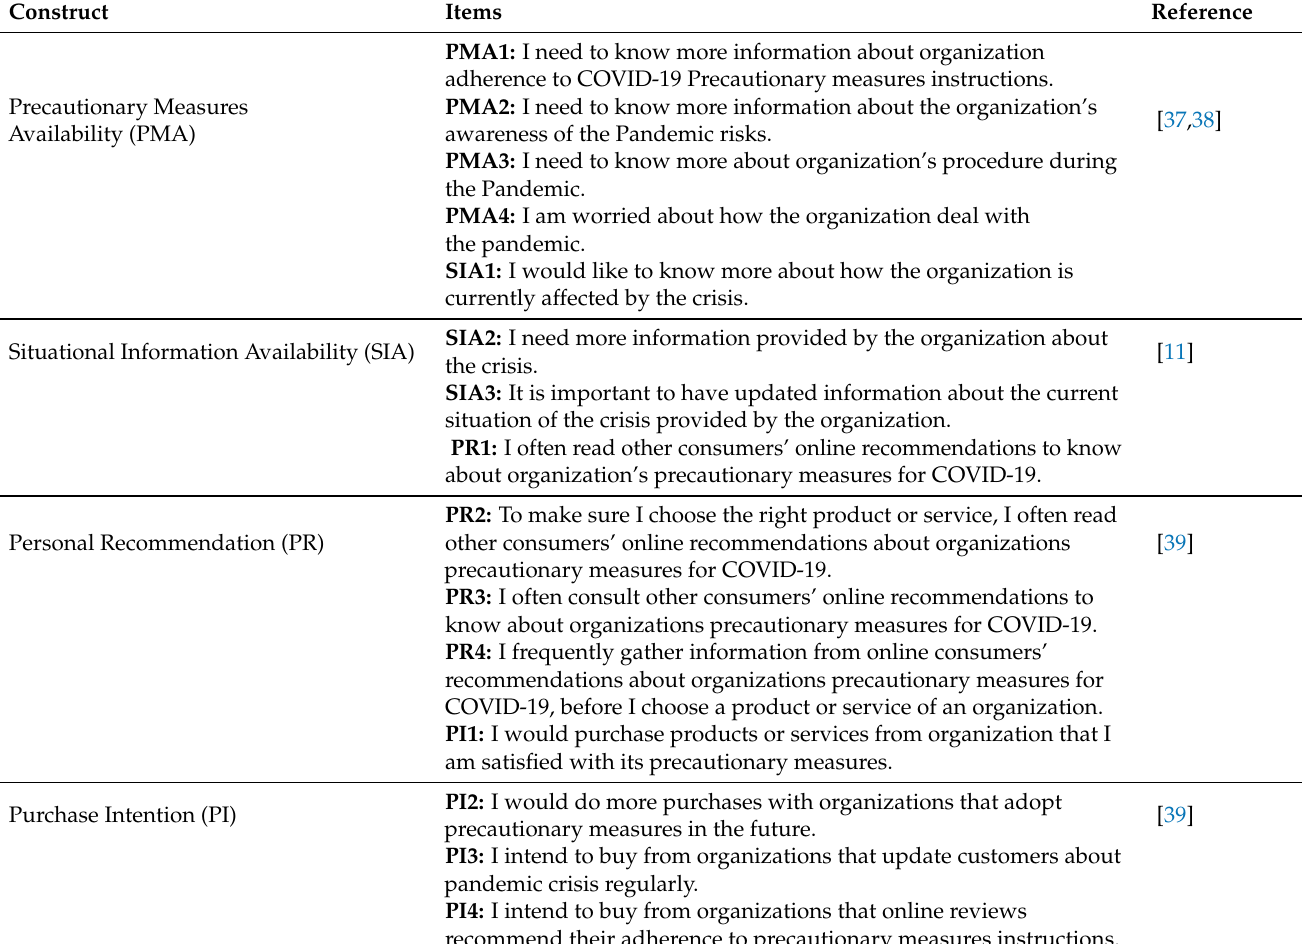
Table 1. Constructs and